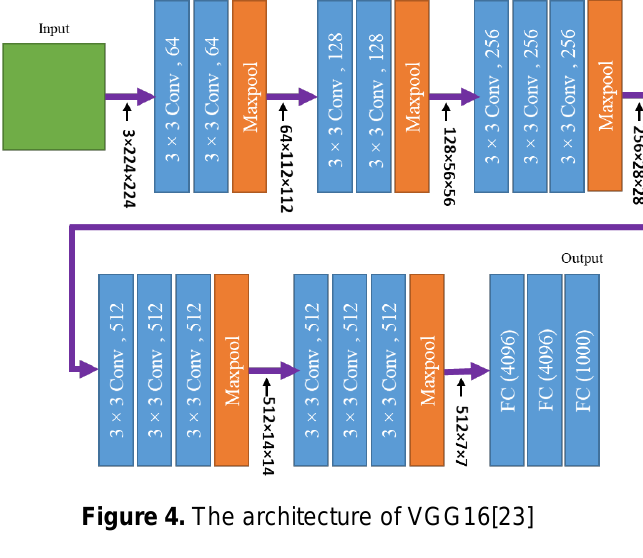
Figure 4. The architecture of VGG16[23]